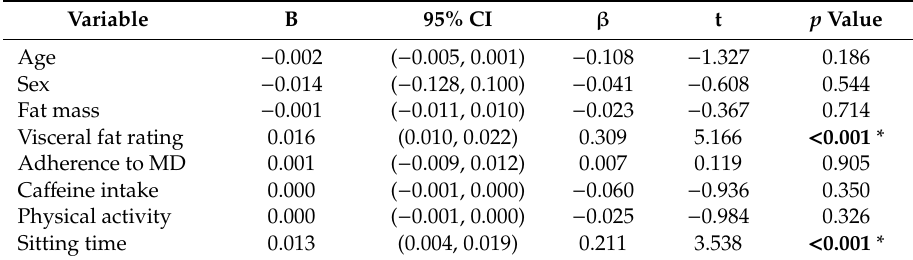
Table 10. Multiple linear regression for tumor necrosis factor (TNF) - α .